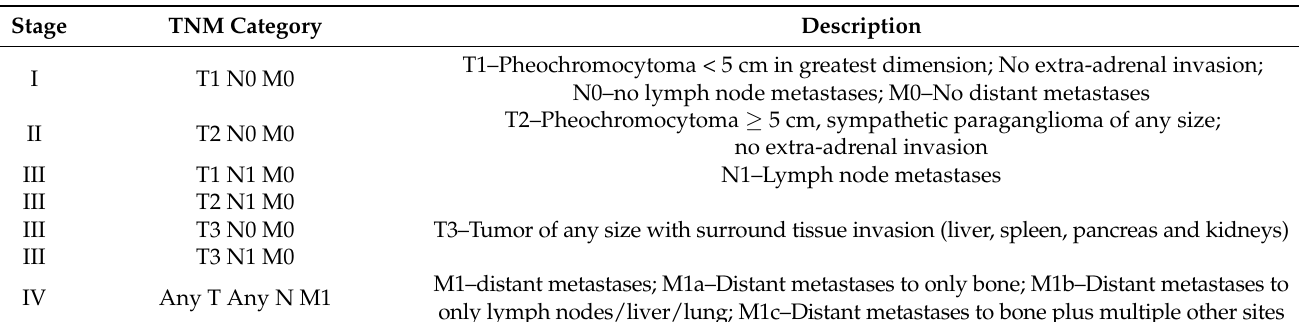
Table 4. AJCC staging of paragangliomas